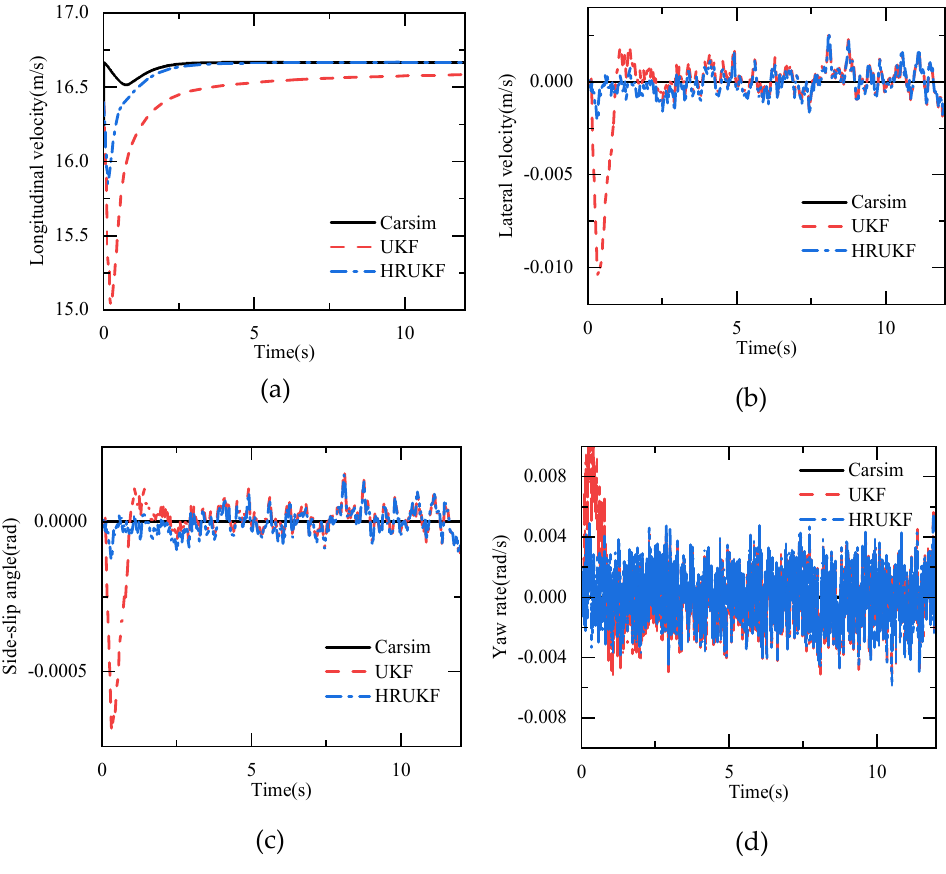
Figure 6. Observation results of vehicle parameters under the straight-line driving condition at constant speed condition. ( a ) longitudinal velocity observation results; ( b ) lateral velocity observation results; ( c ) side-slip angle observation results; ( d ) yaw rate observation results.